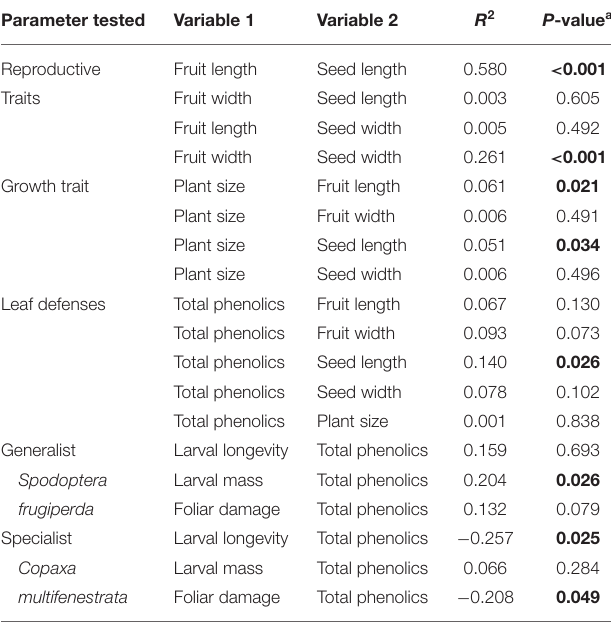
TABLE 1 | Correlation between plant reproductive/growth traits, plant defenses, and insect performance parameters. Parameter